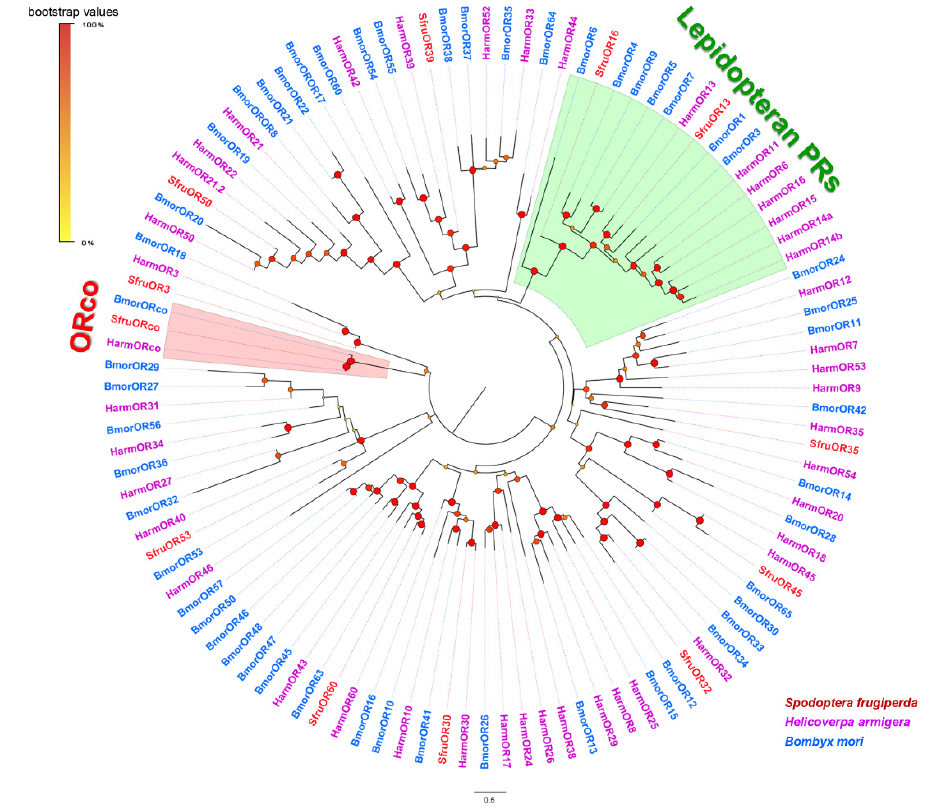
antennae. Although transcripts of SfruORco were also detected in PG-OV, its expression level was much lower than that in the antennae of both sexes (Figure 3).